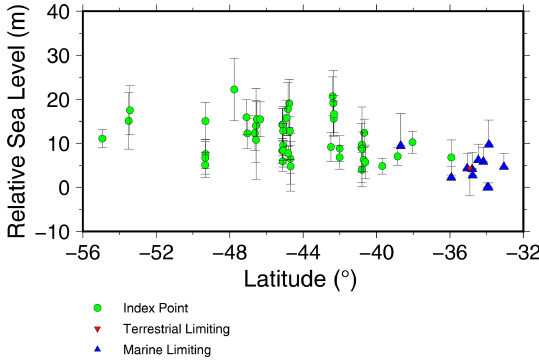
Figure 10. Plot showing the elevation of possible MIS 5 sea-level deposits in southeastern South